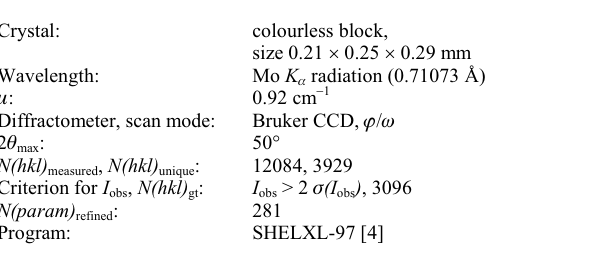
Table 1. Data collection and handling.